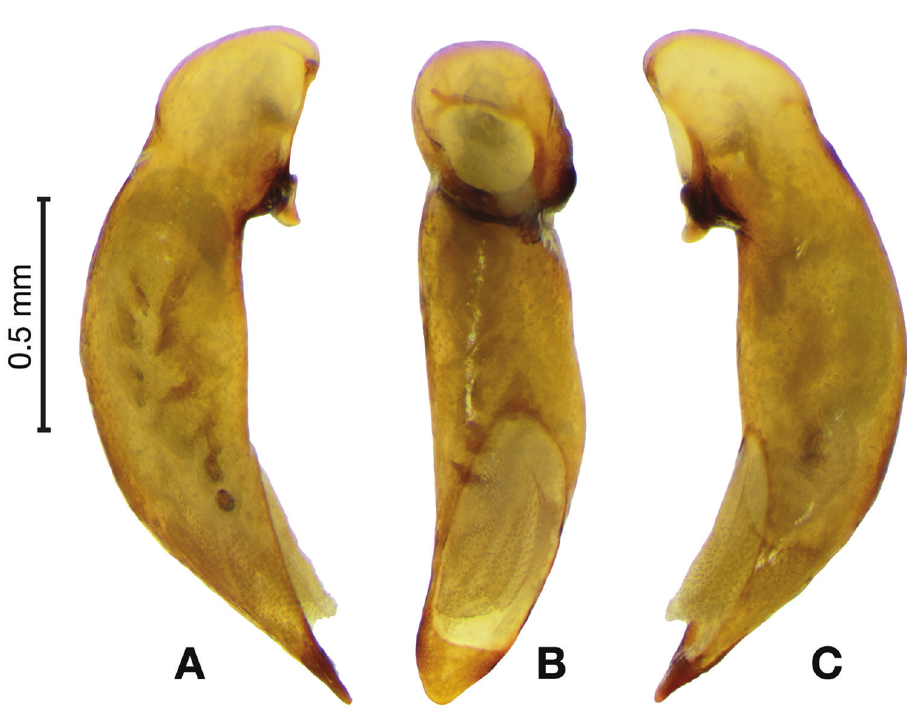
Figure 38. Digital images of male genitalia of C. ( Coptoderina ) chaudoiri Andrewes. A right lateral aspect B ventral aspect C left lateral